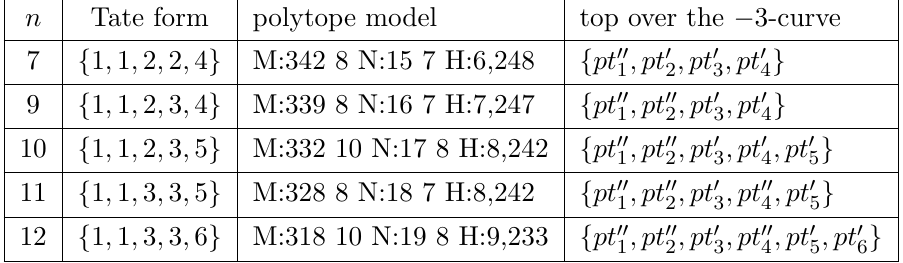
Table 19. Polytope tunings of M:348 5 N:12 5 H:5,251 (generic model over F 3 ): so ( n )-tunings on the (cid:0) 3-curve with n < 13. These are (cid:13)at elliptic (cid:12)bration models, where the Hodge numbers can be directly calculated from the anomaly cancellation